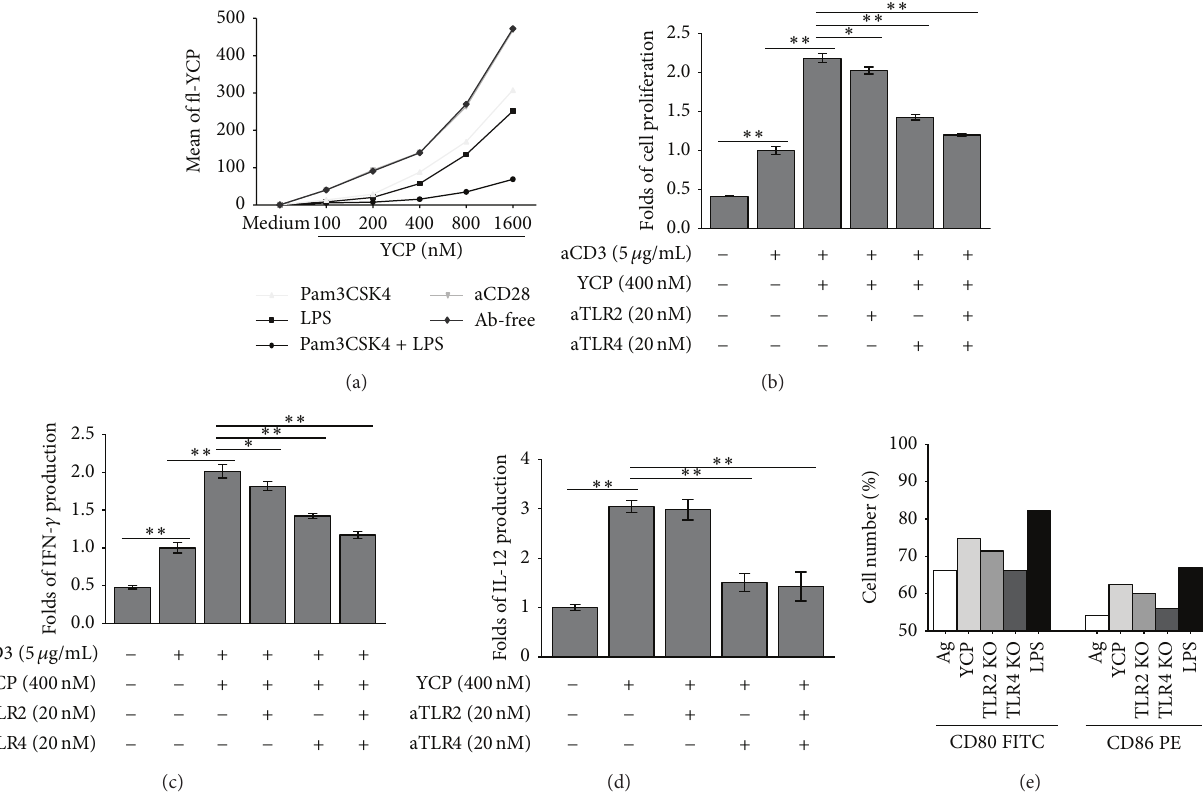
Figure 3: The roles of TLR2 and TLR4 in the actions of YCP on T cells and DCs. (a) Ligand competition experiment on T cells. Splenic T cells were incubated with Pam3CSK4 (a bona fide TLR2 ligand), LPS (a bona fide TLR4 ligand), and anti-mouse CD28 (CD28 ligand) for 1h, followed by fl-YCP (100–1600nM) for 1h in competition experiment analyzed by flow cytometry. ((b) and (c)) Splenic T cells prestimulated with aCD3 or PBS were pretreated with anti-TLR2, anti-TLR4, or both (20nM) for 2 h before the addition of YCP. After 48 h incubation, cell proliferation (b) and IFN- 𝛾 concentration in supernatants (c) were measured using MTT assay or ELISA, respectively ( 𝑛 = 6 , ∗ 𝑃 ≤ 0.05 , ∗∗ 𝑃 ≤ 0.01 by Mann-Whitney 𝑈 test). (d) DCs were pretreated with anti-TLR2, anti-TLR4, or both (20 nM) for 2 h before the addition of YCP. After 48 h incubation, IL-12 concentration in supernatants was measured by ELISA assay ( 𝑛 = 6 , ∗ 𝑃 ≤ 0.05 , ∗∗ 𝑃 ≤ 0.01 by Mann-Whitney 𝑈 test). (e) The expressions of CD80 and CD86 treated by Ag (WT)/YCP+Ag (WT, TLR2 KO mice, TLR4 KO mice)/LPS (WT) were evaluated on